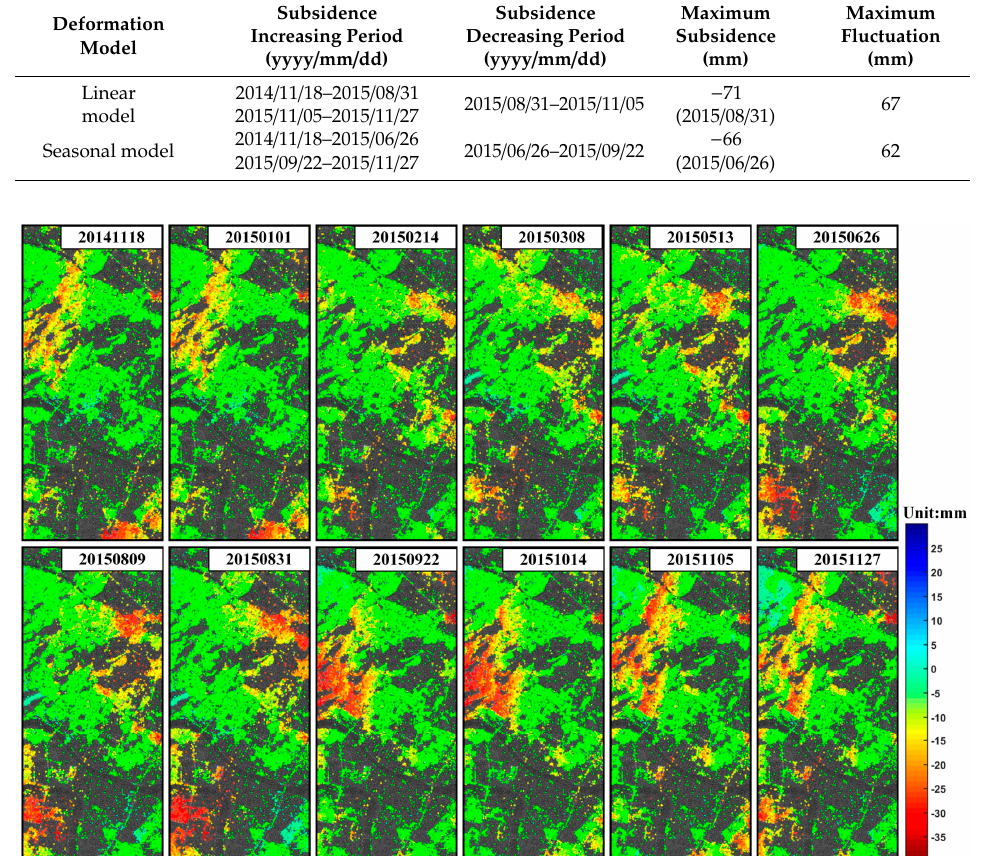
Figure 5. Average linear velocities of Lungui Highway. ( a ) Linear model; ( b ) Seasonal model. Table 2. Comparison of experimental results between the linear model and seasonal model.